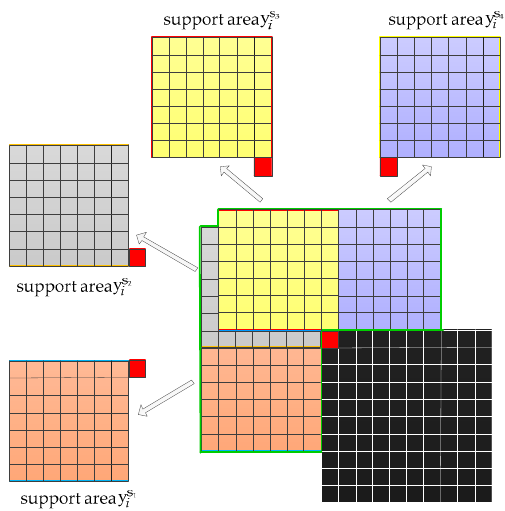
Figure 7. The red square stands for the current missing pixel. Four support area can be found for the currently missing pixel.